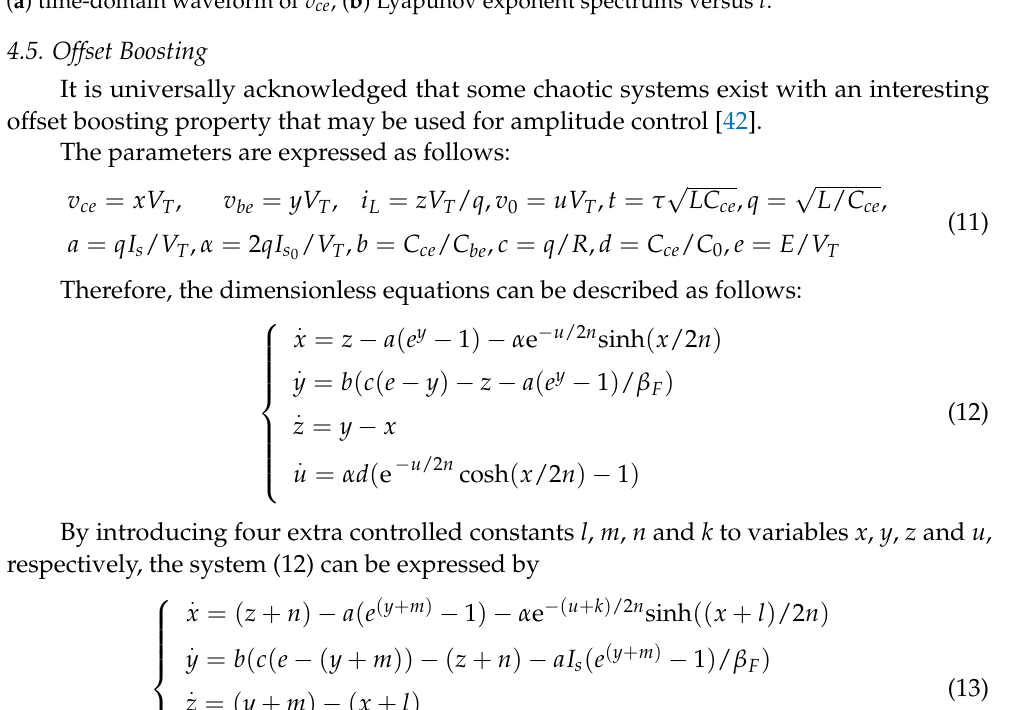
Figure 13. Dynamical behaviors when R = 231 and the initial conditions are [0.1, 0, − 1, 0.1] ( a ) time-domain waveform of v ce , ( b ) Lyapunov exponent spectrums versus t